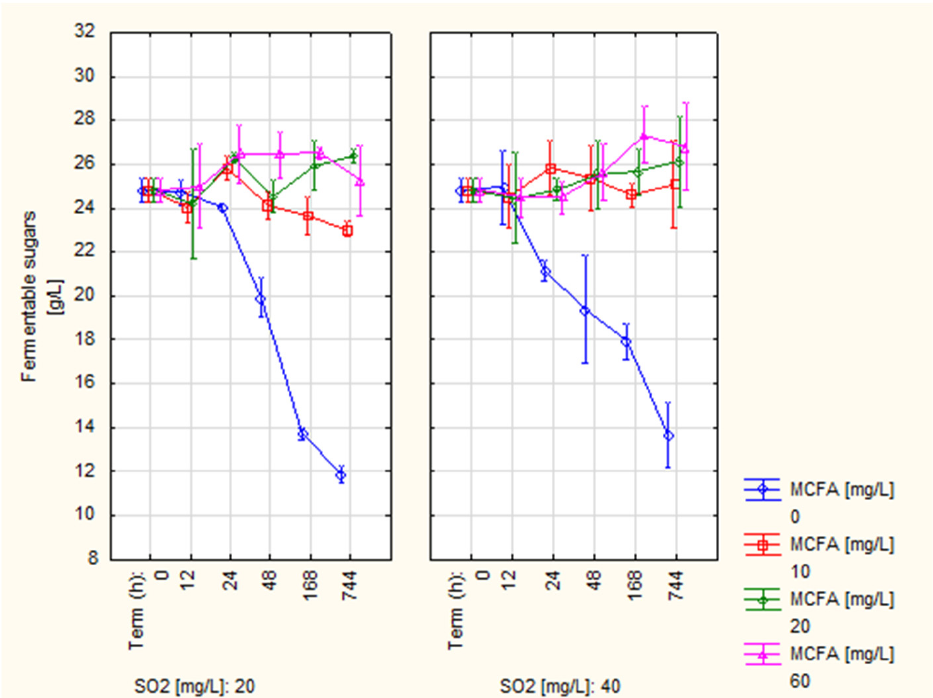
Figure 4. Development of fermentable sugars content.